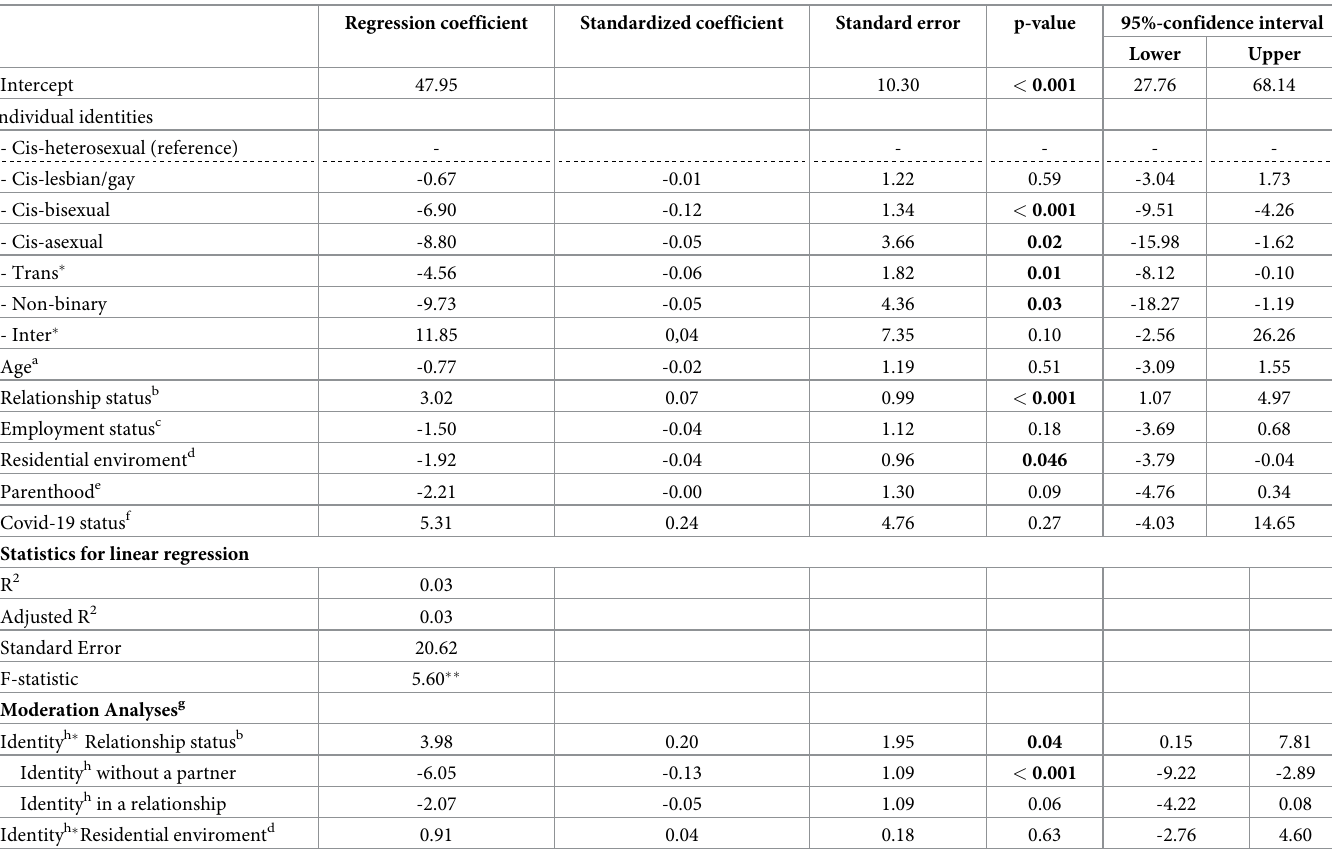
Table 4. Linear regression model with WHO-5 final score as dependent variable and moderation